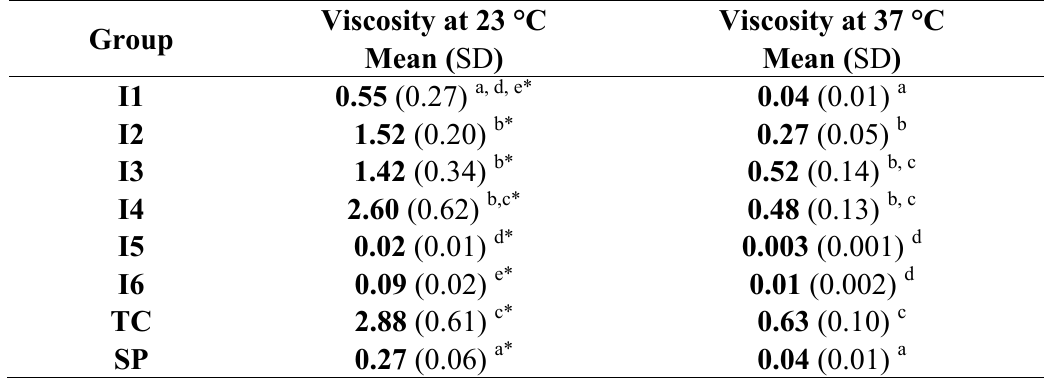
Within each column; different superscript letters indicate significant differences between